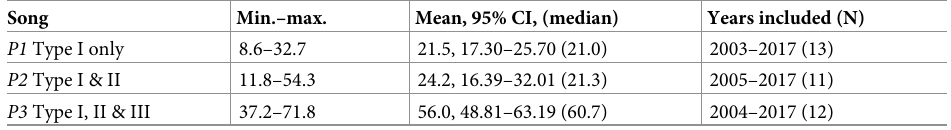
Statistics on proportions of each song-type as given by the feature space analysis of type II to type II time-level